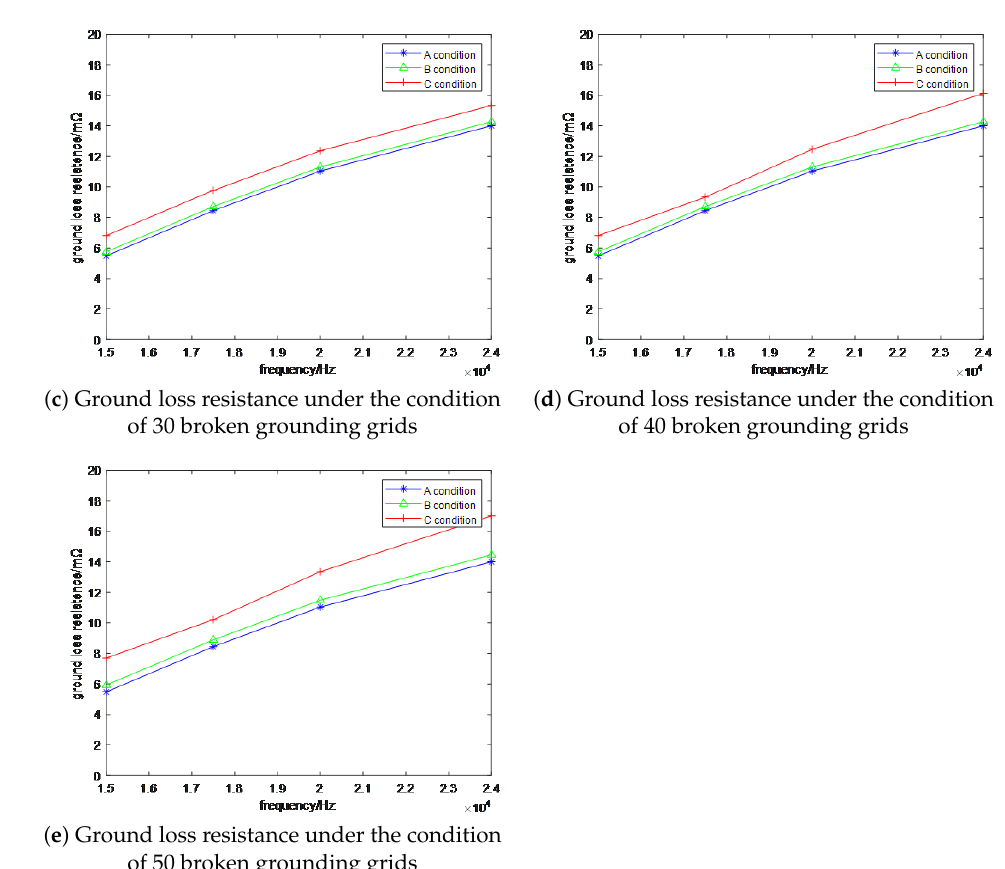
Figure 8. Earth loss resistance under the three conditions A, B and C.